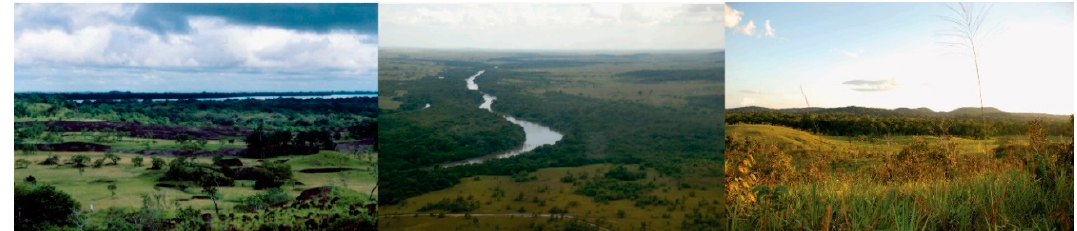
Figure 2. Savannas from left to right of the Llanos in Venezuela with rocky outcrops, Rupununi in Guyana characterized by gallery forest, and Sipaliwini in Suriname with forest on the opposite bank of the river.